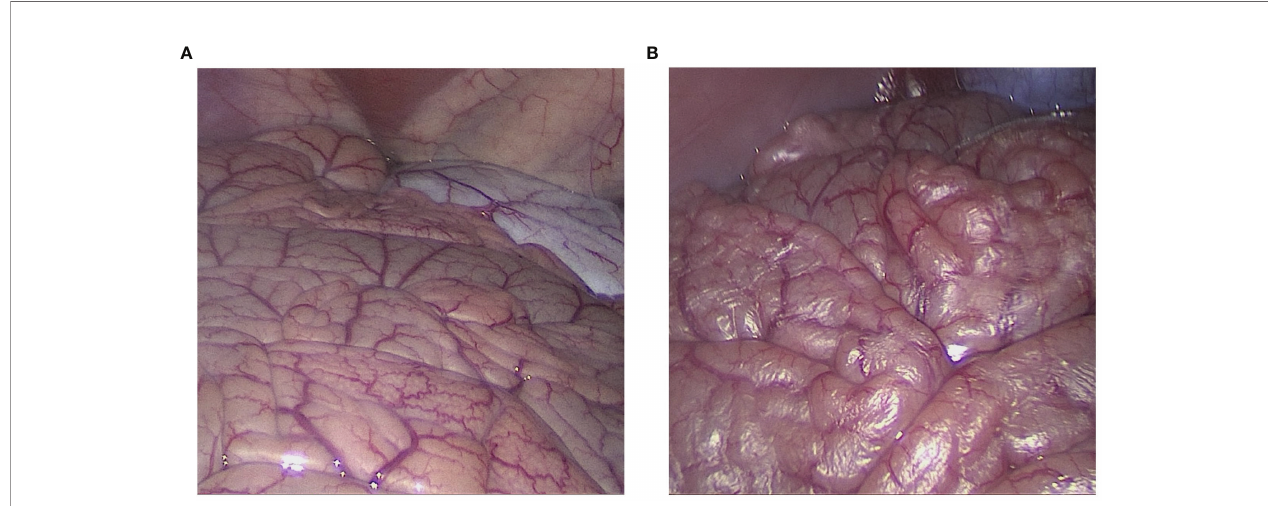
FIGURE 2 | Laparoscopic view of the intraabdominal cavity during high- fl ow air-based hyperthermia. (A) Start of the laparoscopy. The fi gure displays normal small intestinal tissue as is expected during laparoscopy. (B) Laparoscopic view of the intraabdominal cavity after 30 minutes into the procedure. Peritoneal dehydration “ drying ” is visible in the exposed area. The peritoneal surface appears to “ peel-off ” and light re fl ection on the peritoneal surface increases.